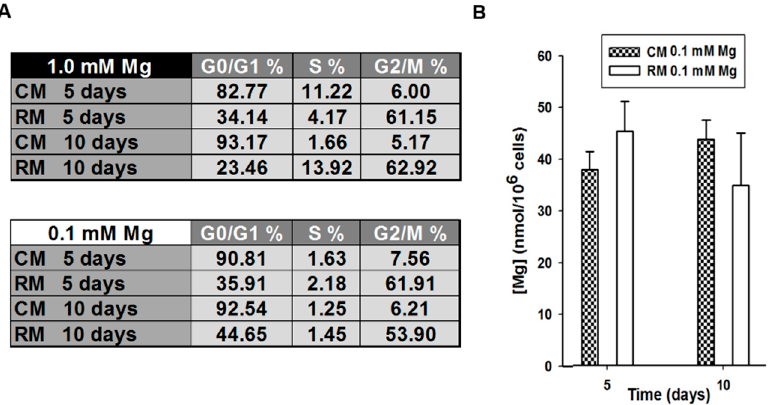
Figure 2. Effects of Mg withdrawal on cell cycle distribution and intracellular Mg concentration in adipose-derived mesenchymal stem cells (AD-MSCs). ( A ) Cell cycle distribution of AD-MSCs cultured in reprogramming medium (RM) or control medium (CM) at 5 and 10 days in physiological concentrations of Mg (upper table) or in Mg-deficient medium (lower table). The results are the mean of three experiments, carried out in triplicate. ( B ) Total Mg concentration was measured in treated (RM 0.1 mM Mg) and untreated (CM 0.1 mM Mg) AD-MSCs after 5 and 10 days in Mg-deficient medium. Measurements were carried out in sonicated sample by using the fluorescent probe DCHQ5.